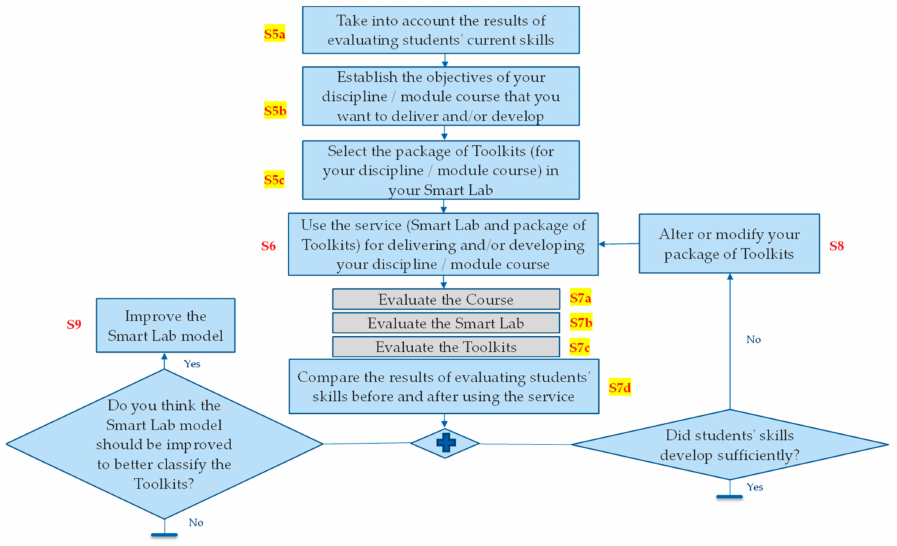
Figure 9. Proposed process for designing and developing the disciplines and module